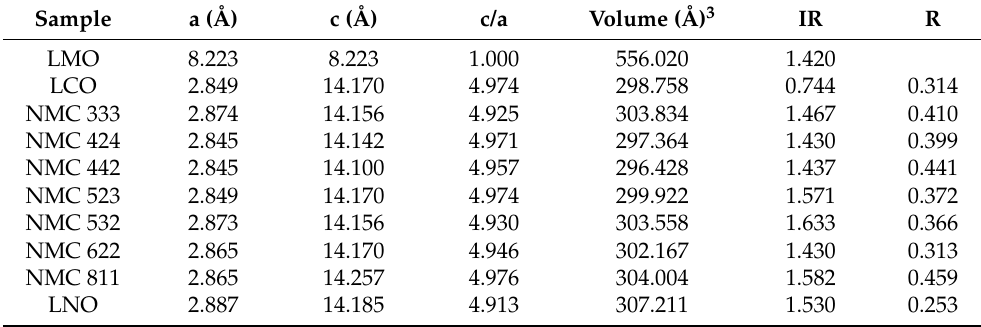
Table 4. The lattice parameter of LMO, LCO, LNO, and NMC at various